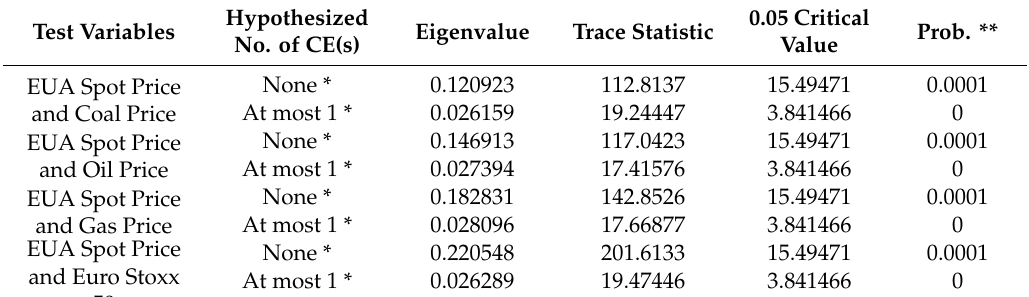
Table 2. Cointegration test results for EUA spot price and its external factors.